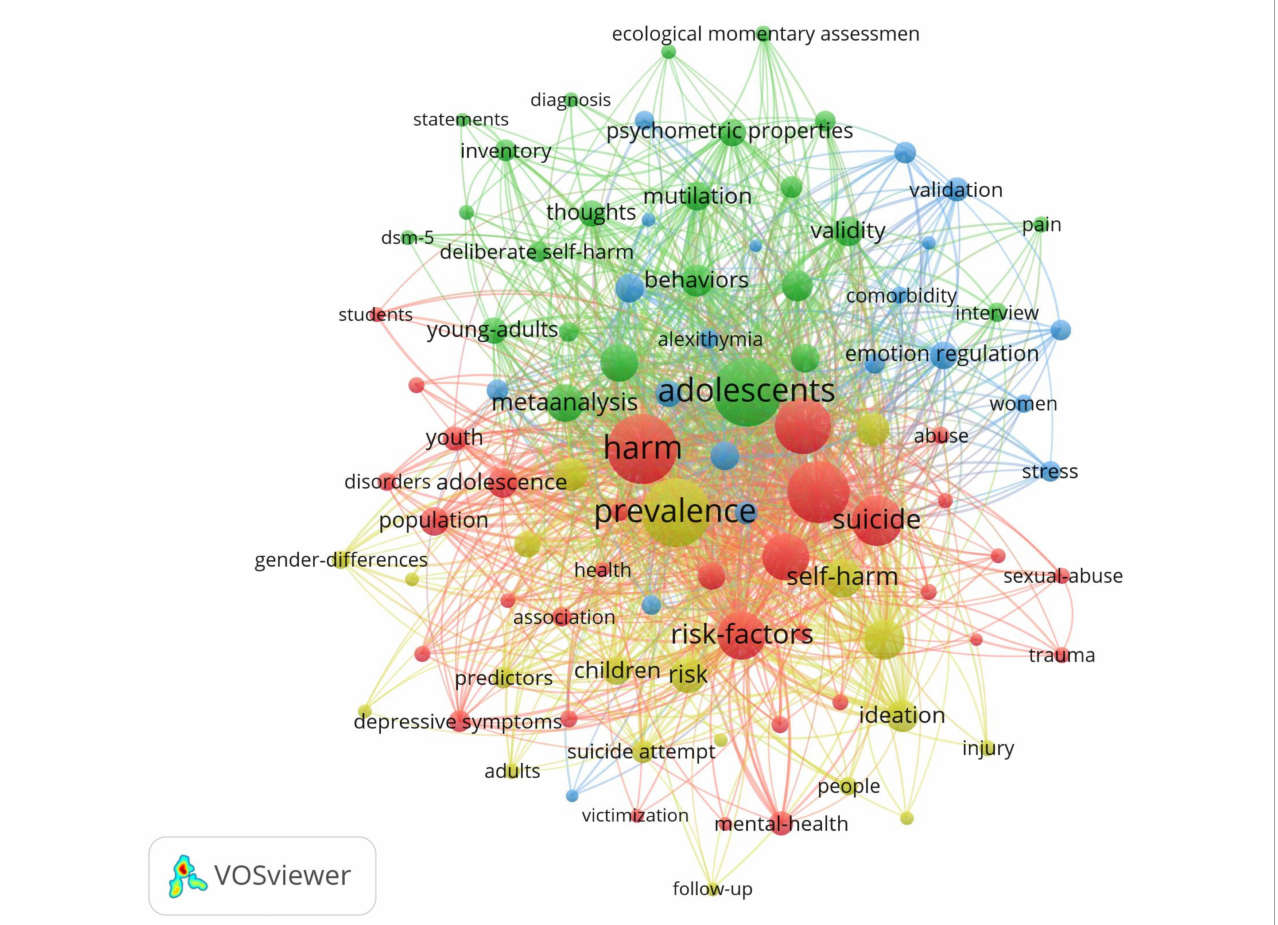
FIGURE12 Keywords cluster analysis co-occurrence map generated by VOSviewer. Each node represents a keywords and each color represents one cluster, the links between nodes represents c0-occurrence of keywords.